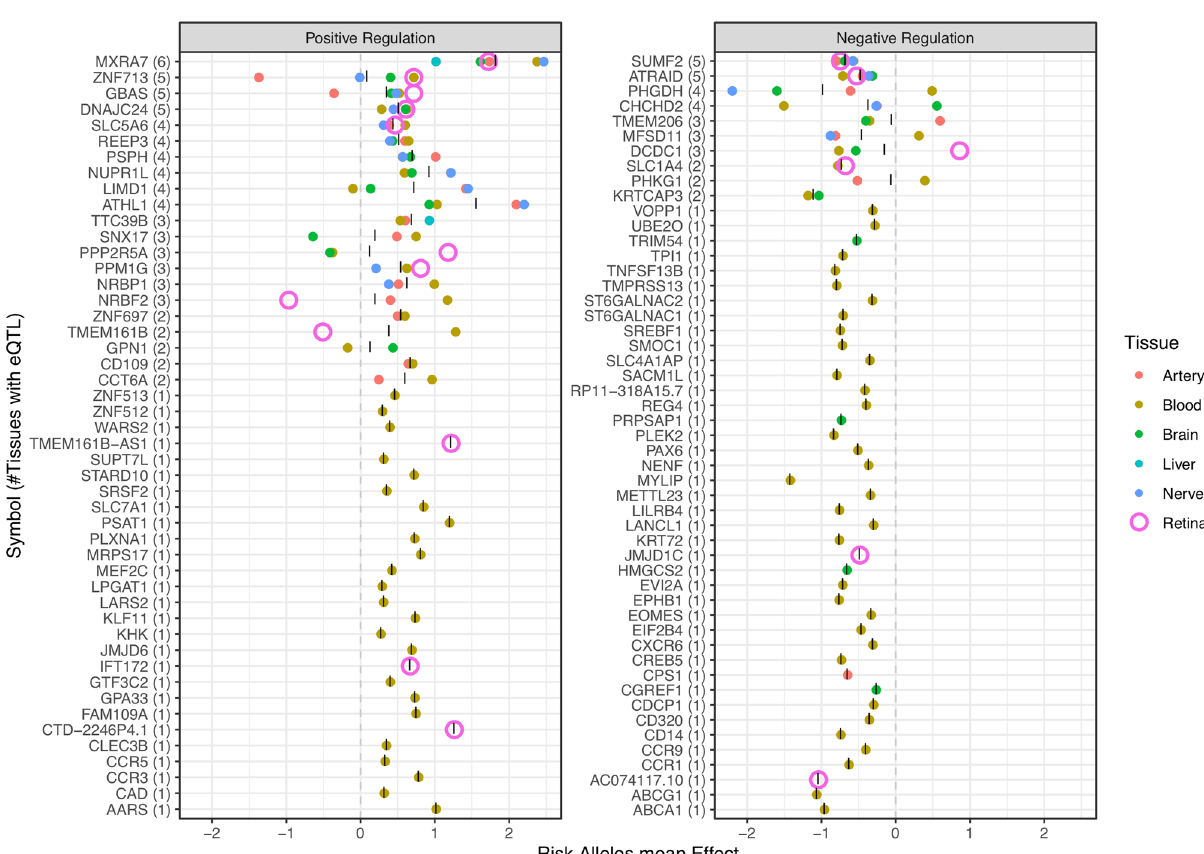
Fig. 3 Expression quantitative trait locus transcriptional effects for MacTel risk alleles (SNPs) across six tissue types. The averaged effects of all proximal SNPs on gene expression across tissue subtypes are represented as coloured points. As the primary disease site, retina is represented as a larger dot for ease of identi fi cation. The mean eQTL effect by tissue type is represented on x -axis while gene symbols are represented on the y -axis. Numbers in brackets denote the number of tissues in which signi fi cant eQTL were detected. Genes are ordered by the sum of tissues in which altered expression is inferred in MacTel. Genes are divided in either positive or negative global regulation de fi ned as the average ‘ |' of eQTL effect across the six tissue groups. *Effect on these genes was detected via trans-eQTL analysis in eQTLGen Genetic correlation between MacTel and other traits . LD score including insulin resistance, anti-cholesterol medication, regression between MacTel and 650 selected phenotypes revealed increased body fat and diabetic eye disease, were positively cor- 99 nominally signi fi cant associations, of which use of medications related with MacTel. Whereas triglyceride and very-low-density for ‘ pain relief, constipation and heartburn ’ was the most sig- lipoprotein (VLDL) serum concentrations were positively asso- ni fi cant ( P < 10 × 10 − 5 ; Supplementary Data 14). Related to this, ciated, high-density lipoprotein (HDL) concentrations were pain in the neck, face, limbs and joints, and neuropathy of the negatively correlated with MacTel genetic risk factors. Of note, upper limbs were also correlated with genetic risk factors for retinal detachment and breast cancer were also negatively cor- MacTel. In addition, type II diabetes-related phenotypes, related with this disease (Supplementary Data 14).